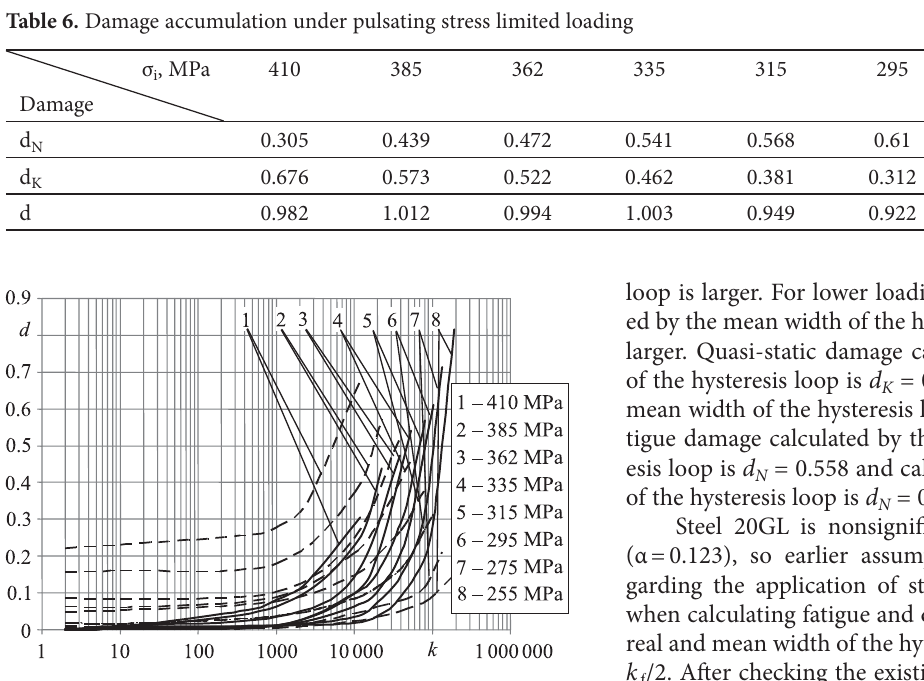
Fig. 9. Damage variation in pulsating loading: _______ fatigue damage, _ _ _ _ quasi-static